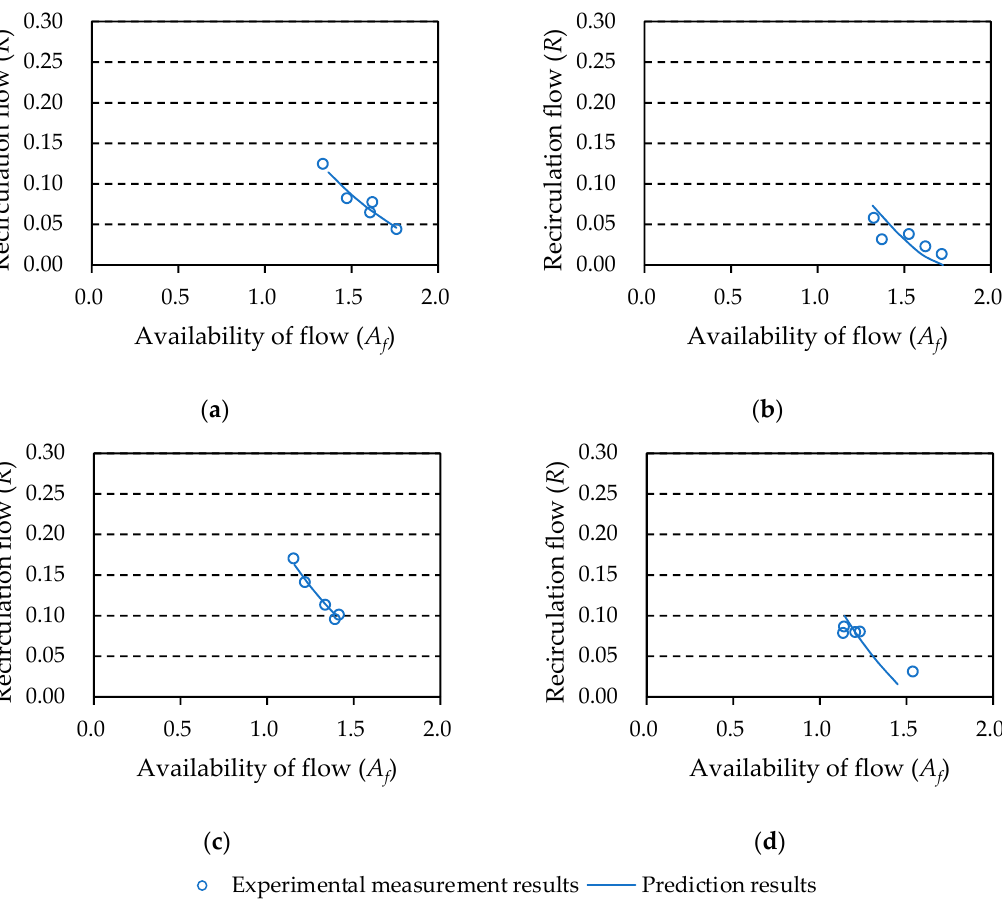
f ) decreases, recirculation flow ( R ) tends to increase. In other words, it can be said that the amount